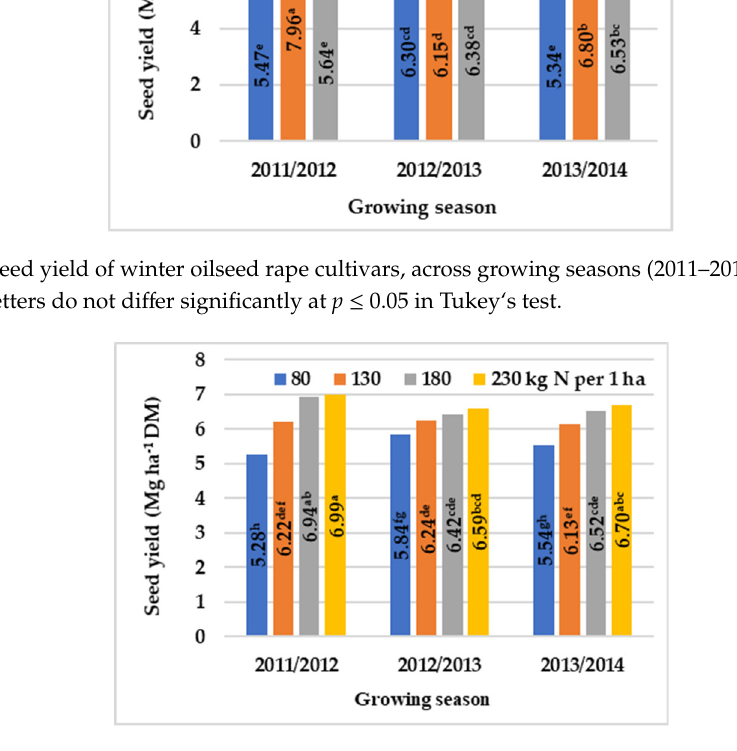
Figure 2. The effect of nitrogen (N) fertilization on the seed yield of winter oilseed rape, across growing seasons (2011–2014). Means with the same letters do not differ significantly at p ≤ 0.05 in Tukey‘s test.